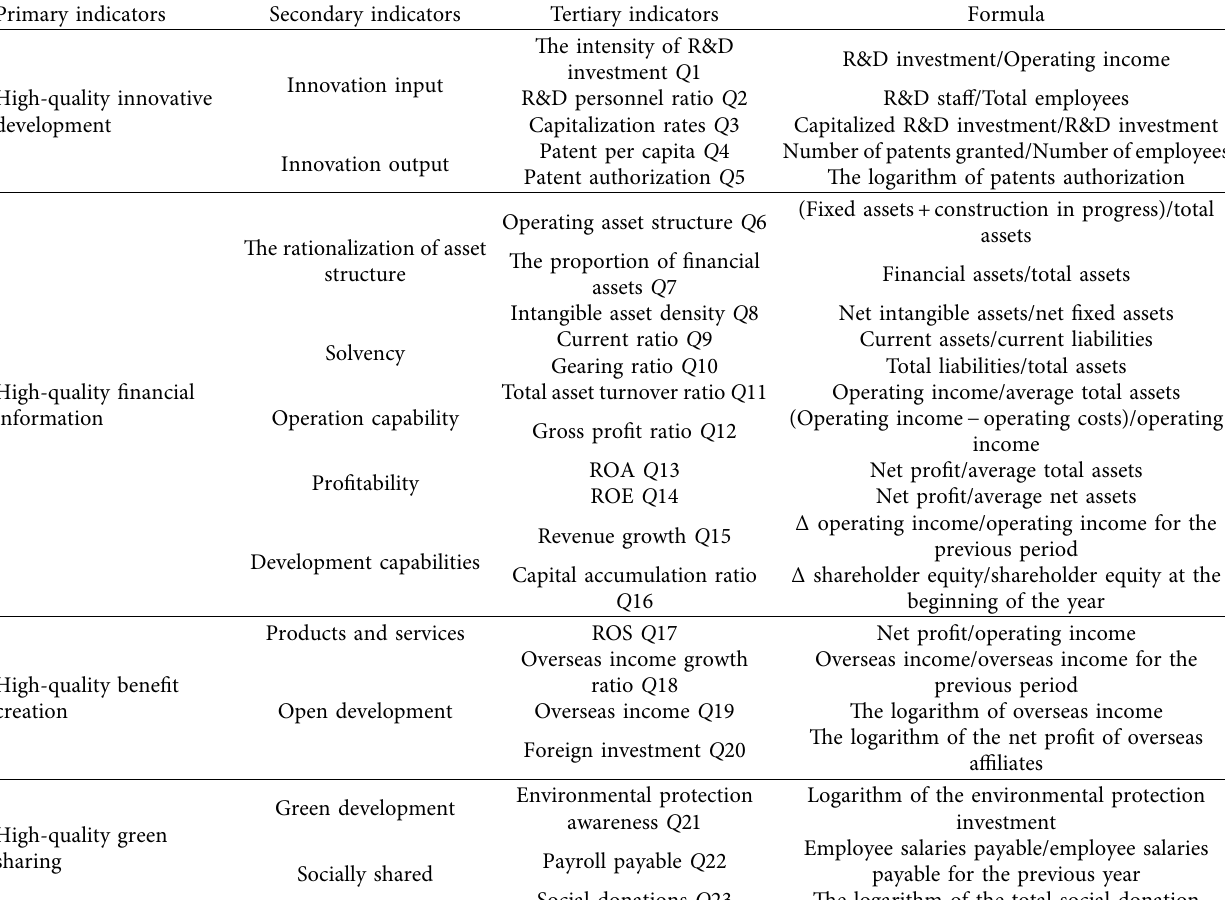
Table 1: The original high-quality development evaluation index